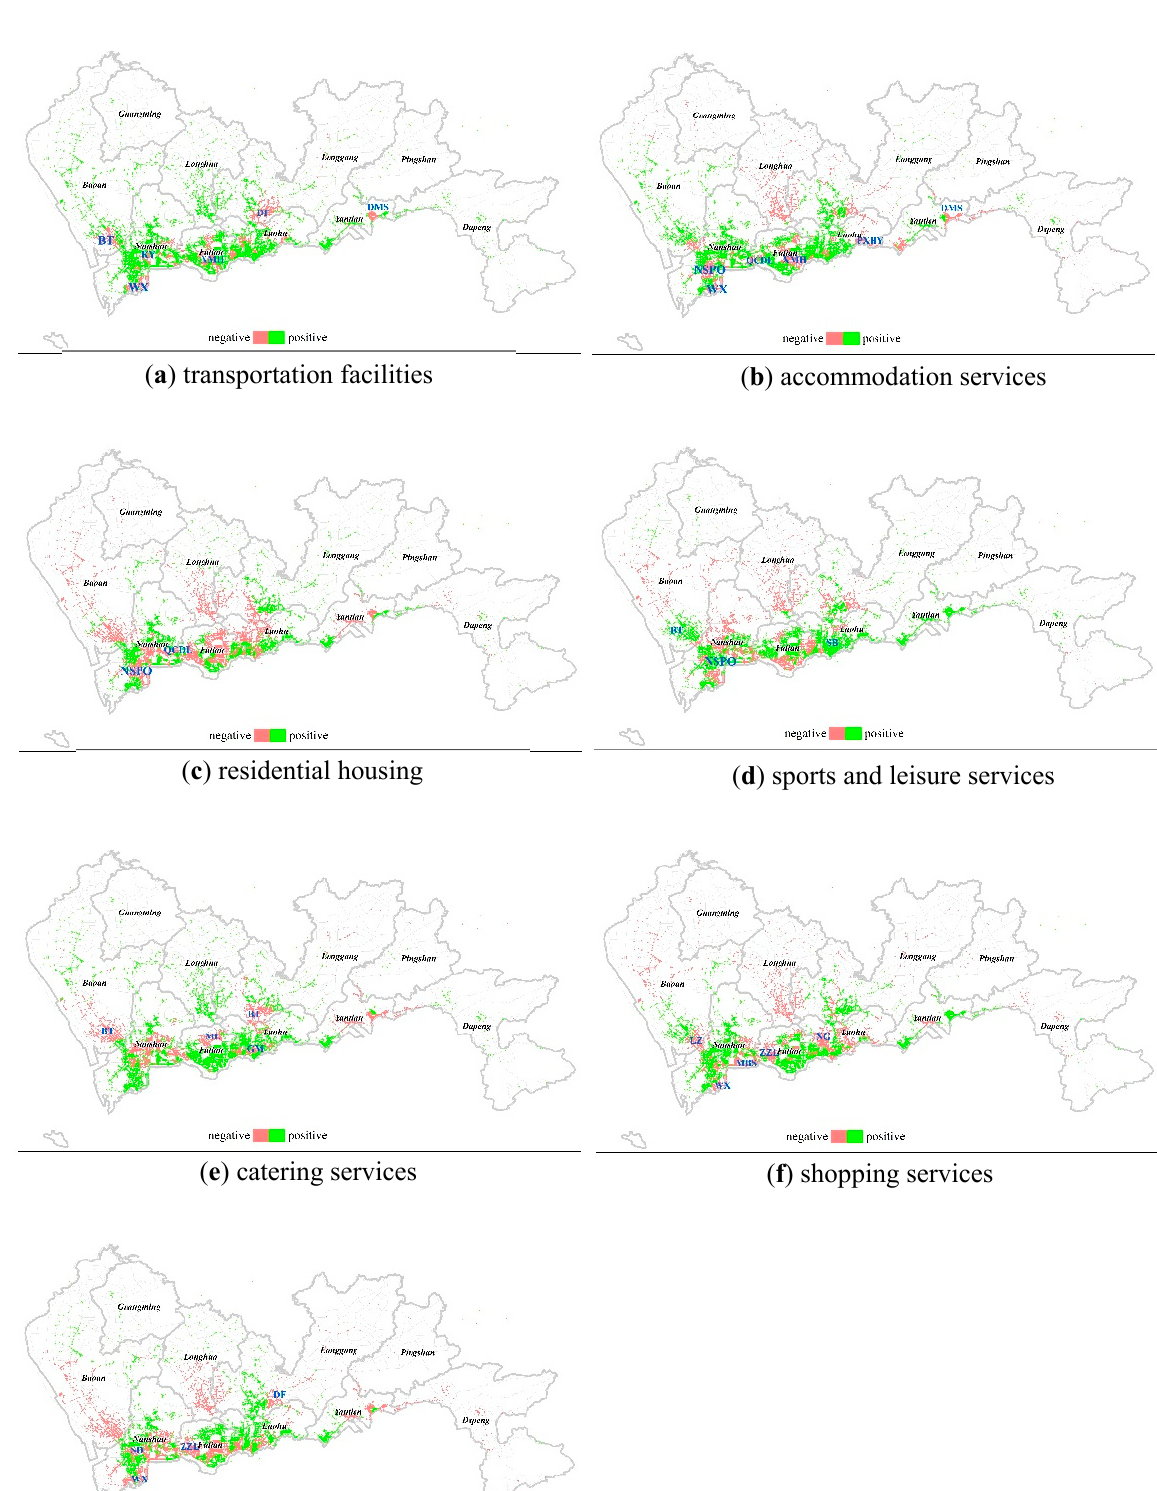
Figure 8. ( a – g ) Maps of regression coefficients.